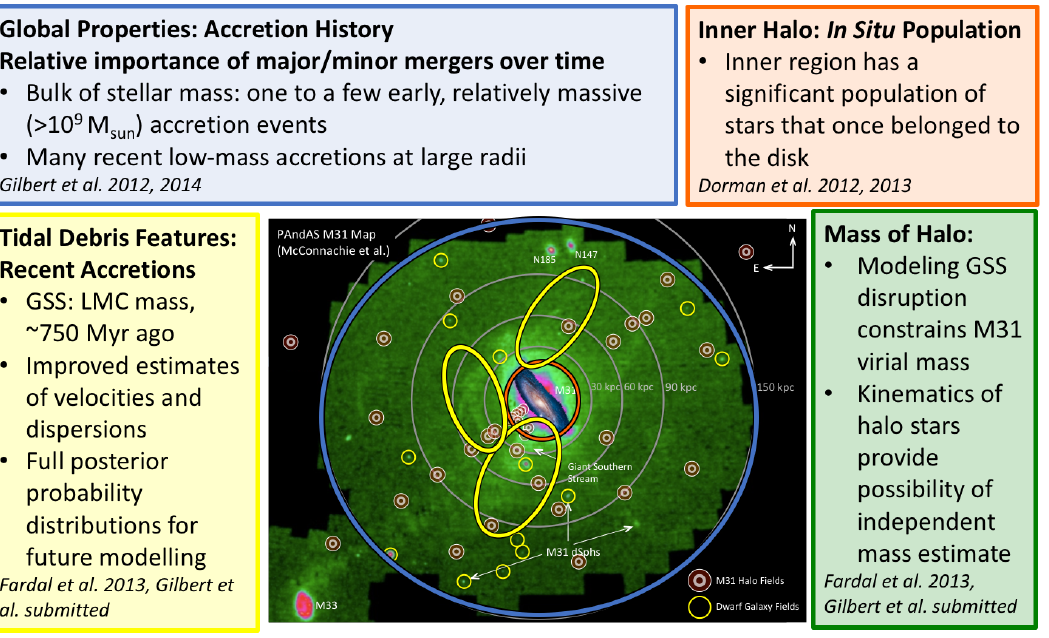
Figure 6. A summary of the major inferences that can be made about the formation of M31’s stellar halo from measurements made using the SPLASH dataset. The underlying figure is the same as in Figure